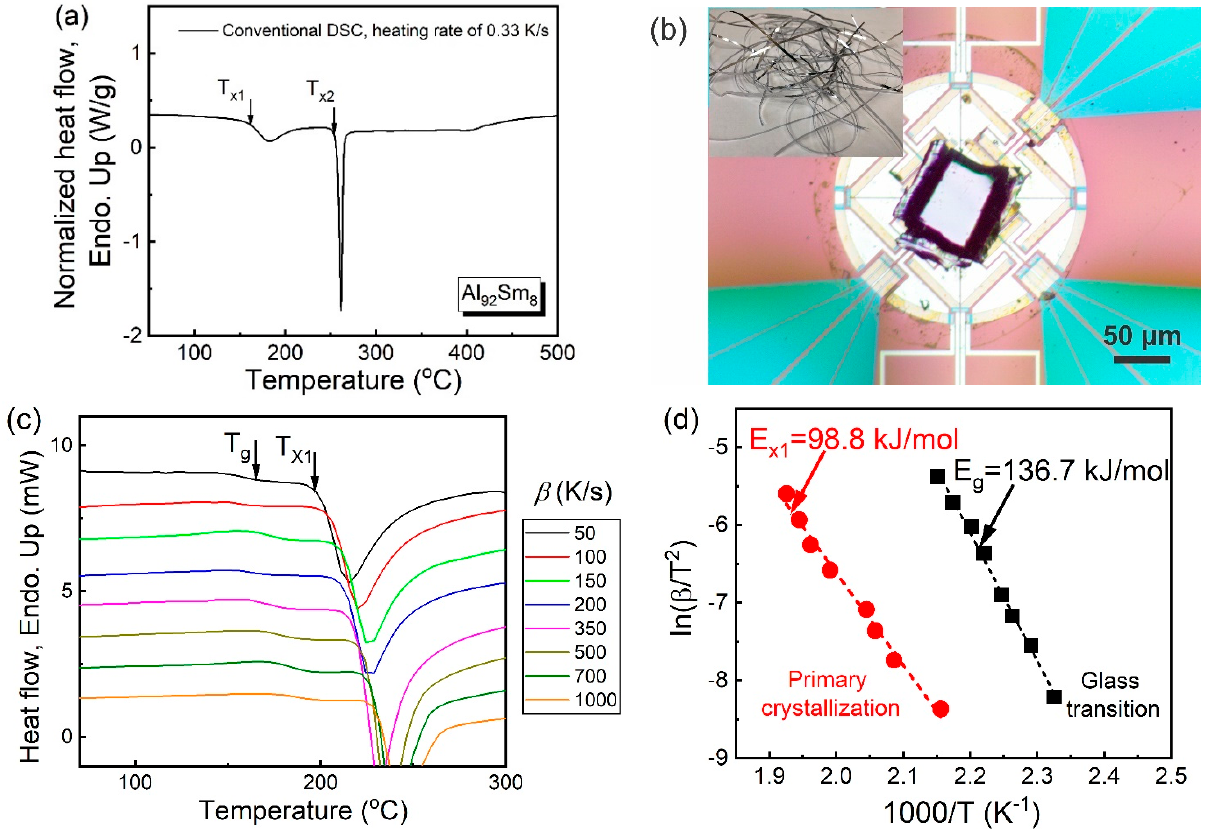
Figure 1. ( a ) Heat flow curve by conventional DSC with the heating rate of 0.33 K/s for Al 92 Sm 8 MG; ( b ) optical picture of tiny MG sample on Flash DSC chip (the left inserted picture gives the optical photo of ribbon-like MG sample); ( c ) a series of Flash DSC heat flow curves by Flash DSC with the heating rates ranging from 50 to 1000 K/s; and ( d ) activation energies of glass transition and primary crystallization by fitting the experimental T g and T X1 based on the Kissinger equation.